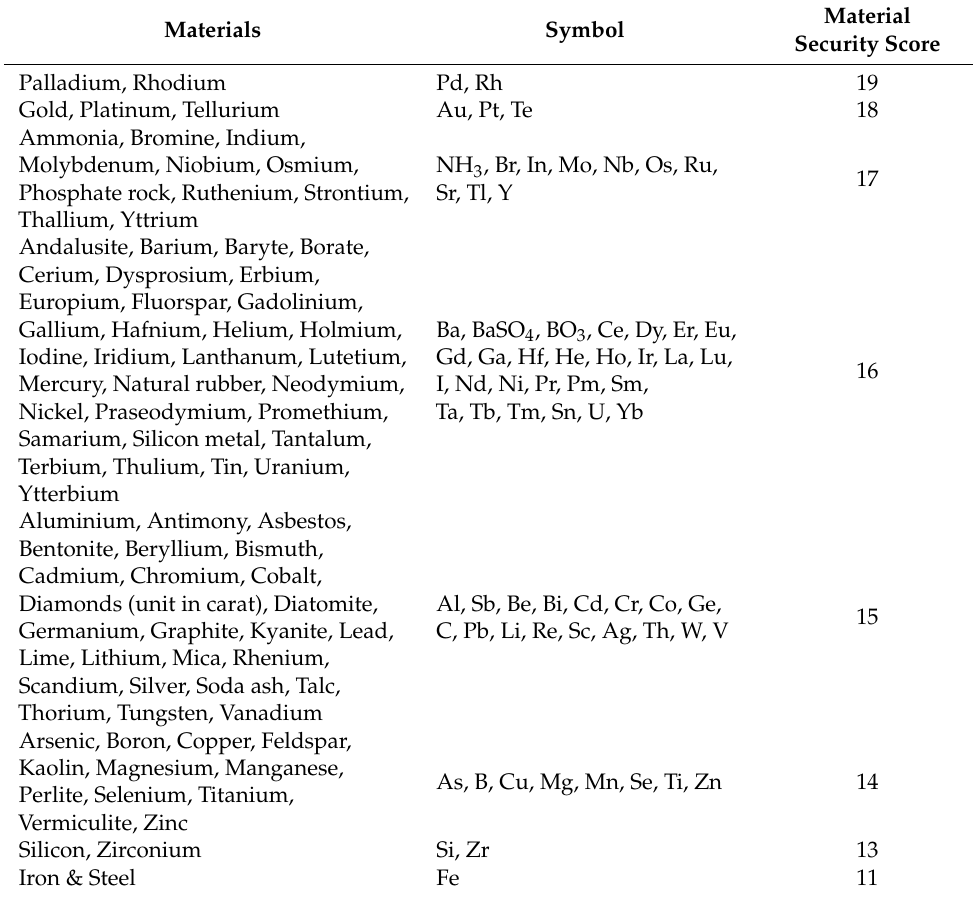
Table 7. Material groupings that are critical to the Malaysian